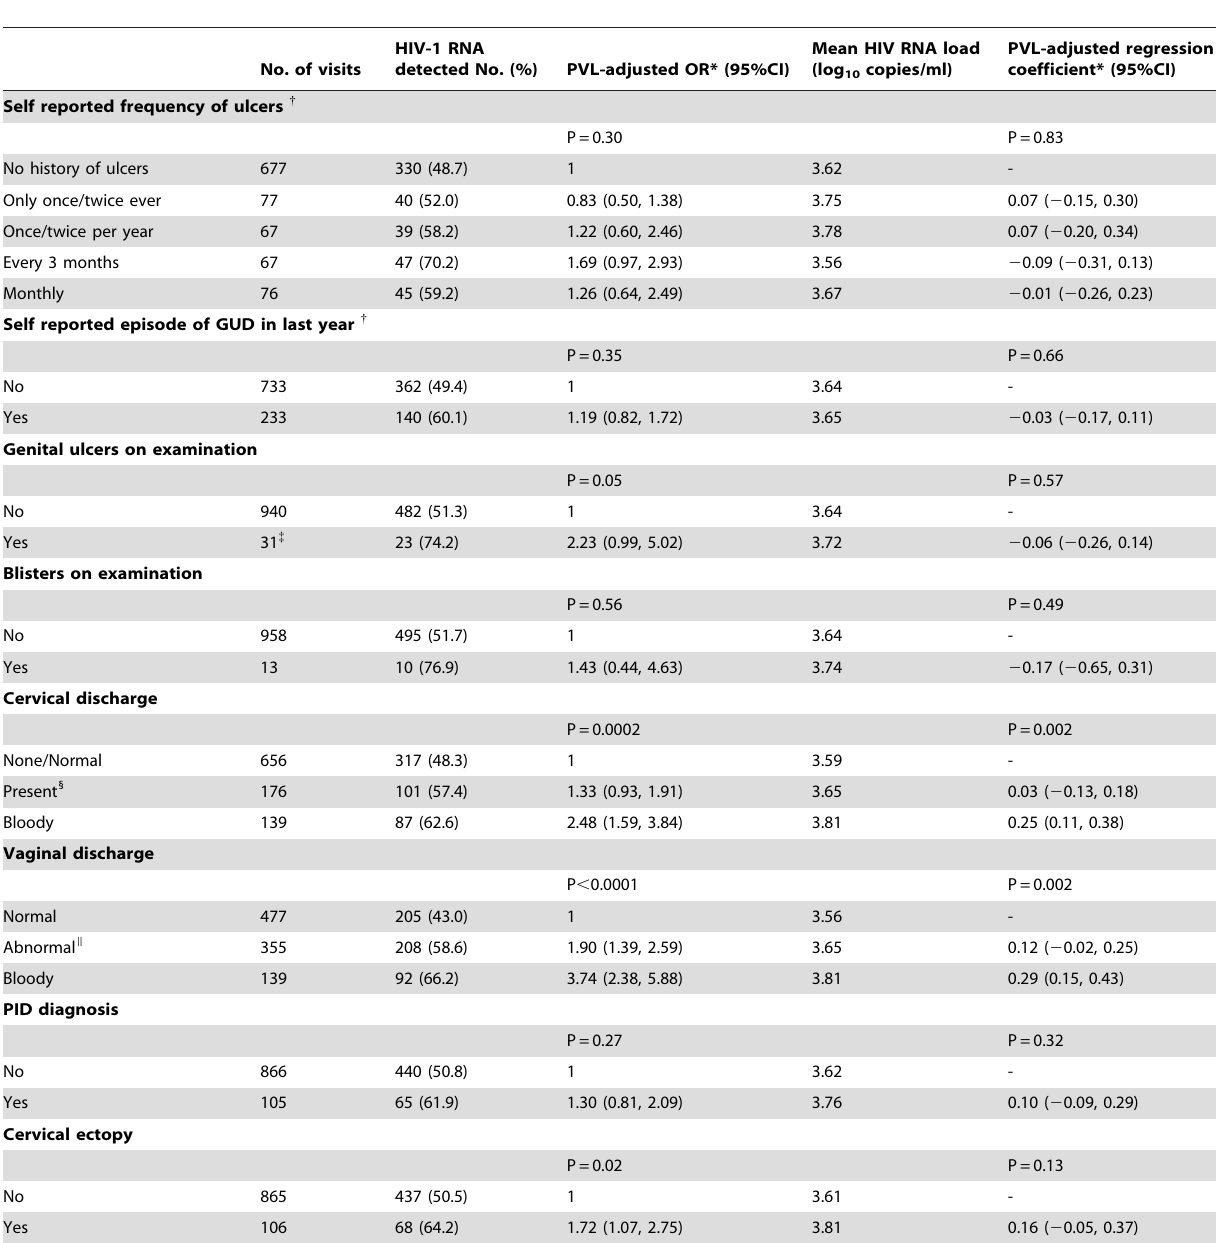
Table 2. Behavioural characteristics and association with cervico-vaginal HIV-1 RNA detection (in 482 women at 971 visits) and HIV-1 RNA